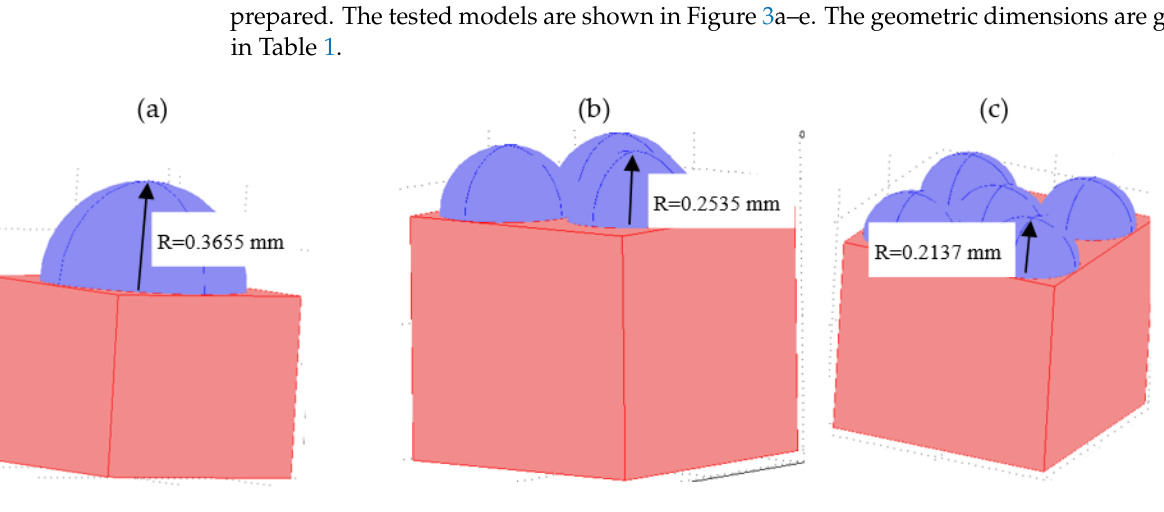
Figure 3. Exemplary geometrical models in the calculation program Comsol: ( a ) 1 hemisphere, ( b ) 3 hemispheres, ( c ) 5 hemispheres, ( d ) cube, ( e ) part of hemisphere. Table 1. Geometric dimensions of numerical models in relation to unit value.